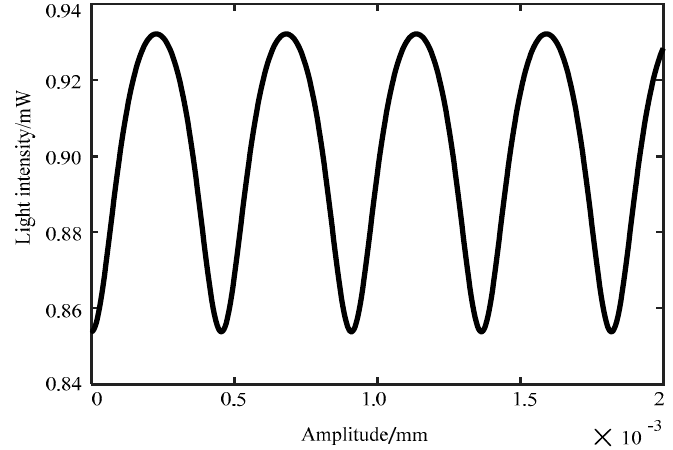
Figure 2. The relationship between interference intensity and amplitude.